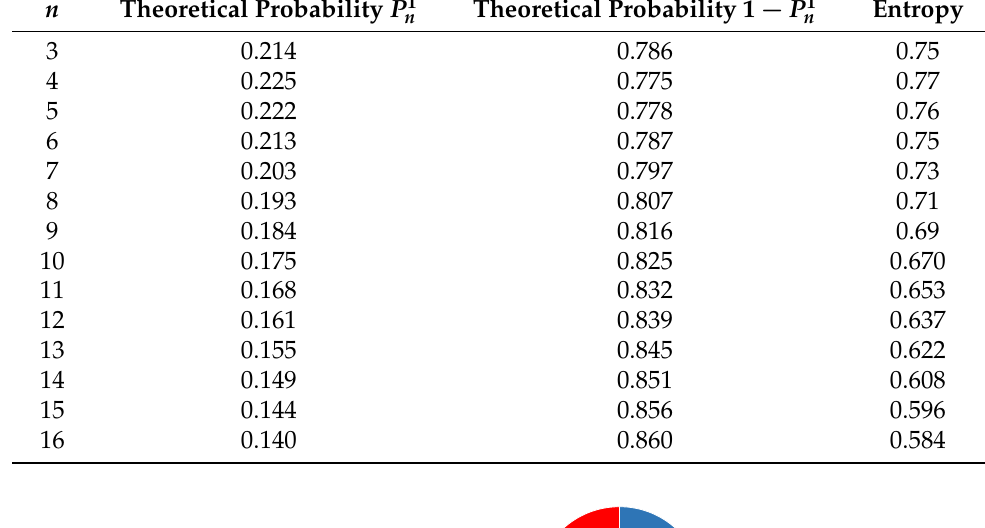
Table 1. Values of the theoretical probabilities P 1 n and ( 1 − P 1 n ) of Proposition 1, n = 3, . . . ,16.